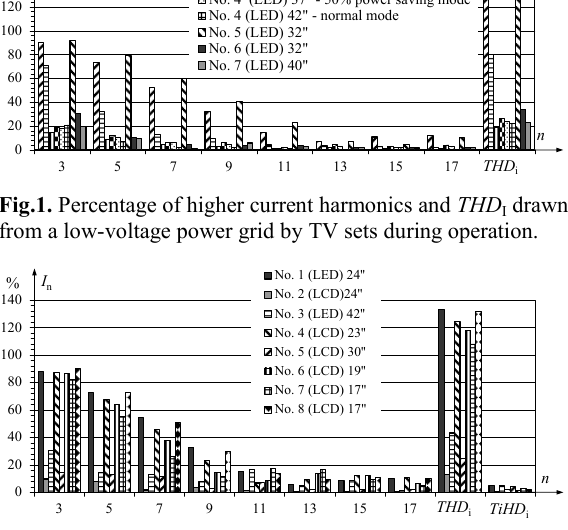
Fig.2. Percentage of higher current harmonics and THD I and TiHD I drawn from a low-voltage power grid by monitors during operation. Part